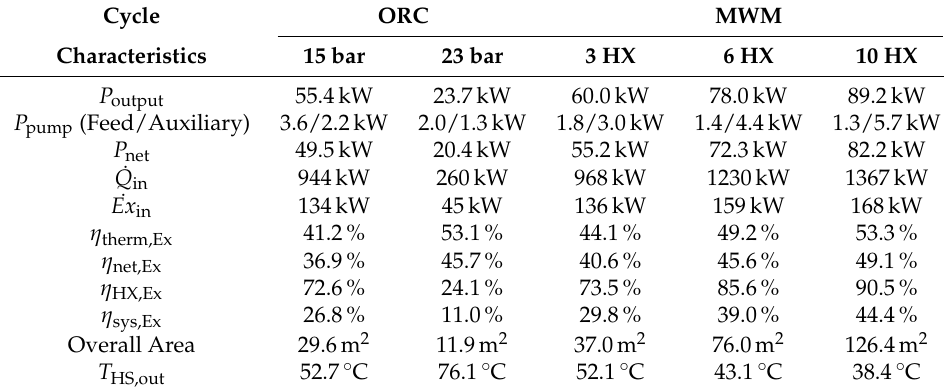
Table 3. Results for the ORC and Misselhorn